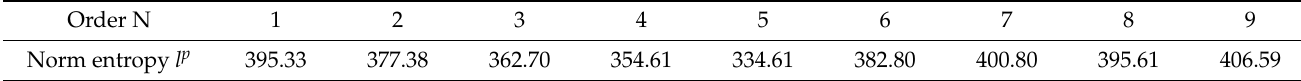
Table 5. Norm entropy l p in different order N of the Daubechies wavelet